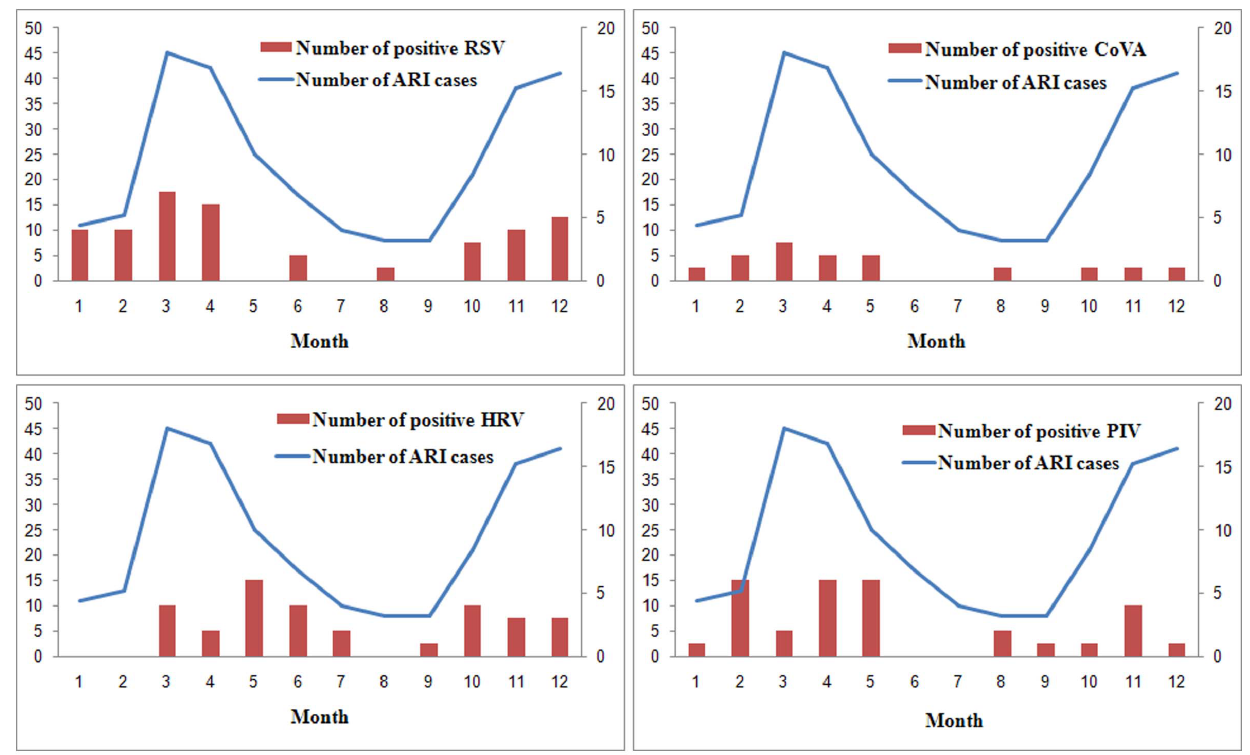
Figure 1. Viral pathogens distribution in different season.